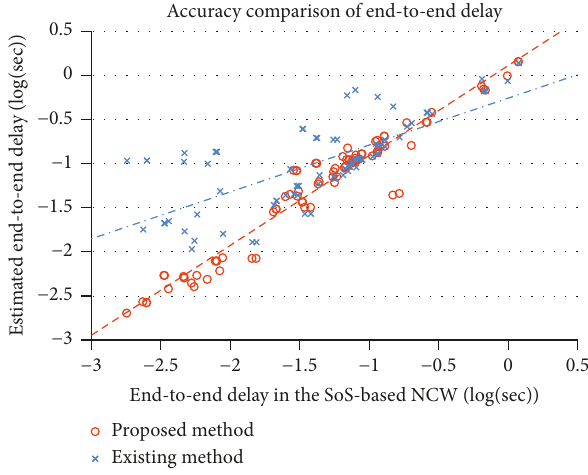
Figure 12: Simulation results for end-to-end delay comparing between the existing and the proposed